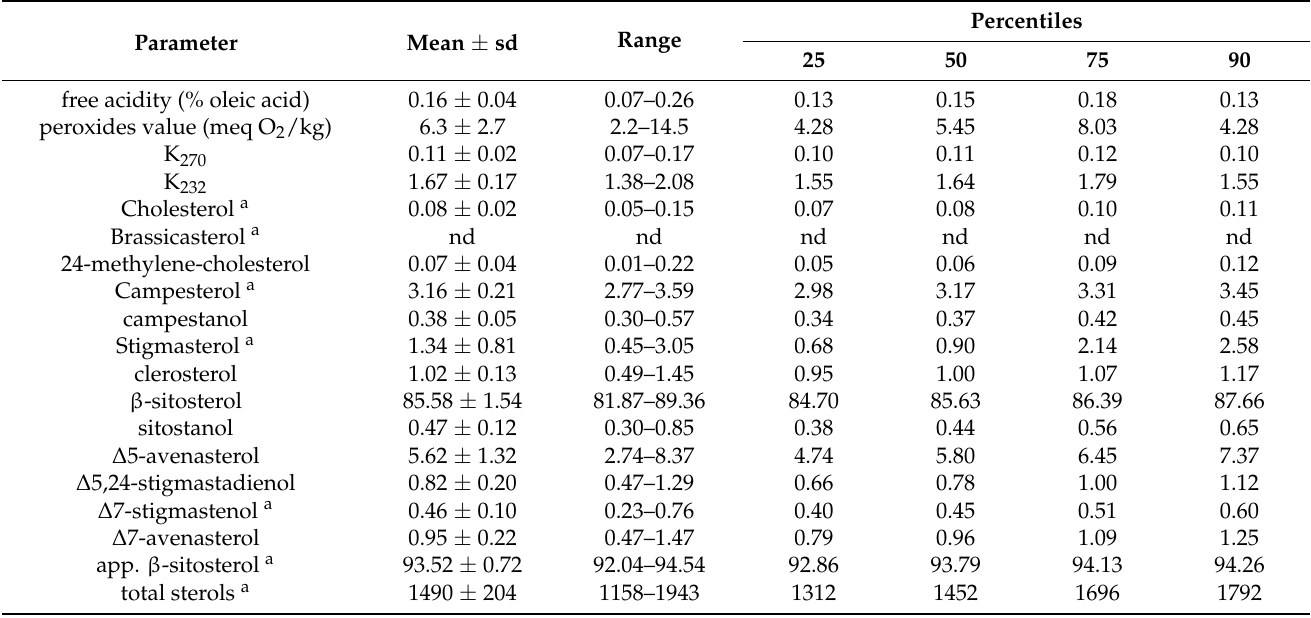
Table 1. Descriptive statistic of physicochemical quality parameters and sterol composition during three crop years (2017, 2018, and 2019) ( n =